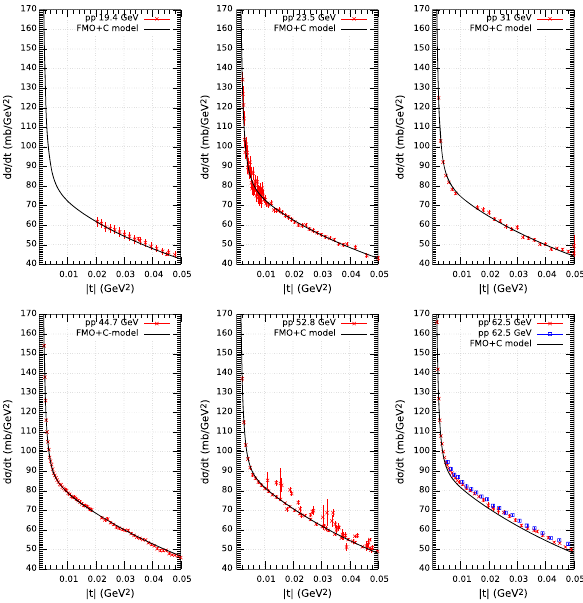
Fig. 5 Differential pp cross sections at the lowest | t | and at ISR ener- gies